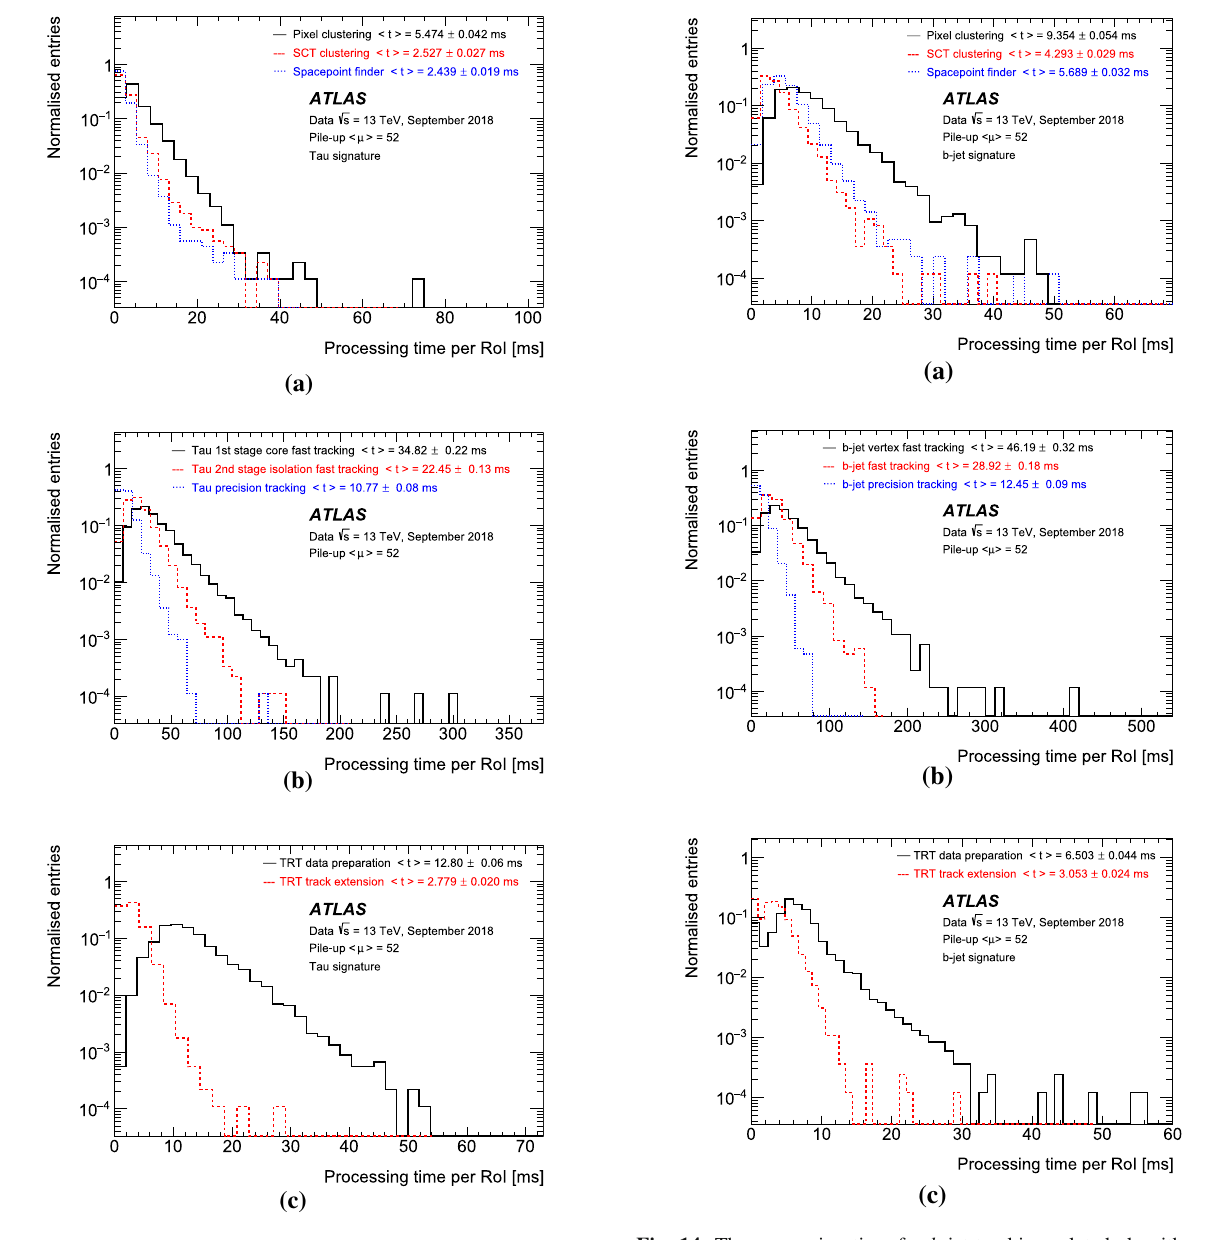
Fig. 13 The processing time for tau tracking related algorithms; a the data preparation times, b the tracking algorithm times, and c the TRT data processing